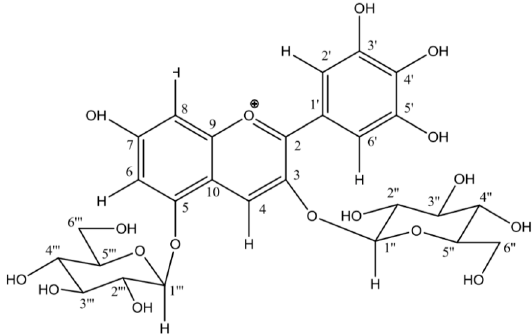
Figure 5. Structure of delphinidin 3,5-di- O - β -glucoside found in Crocus sativus L.